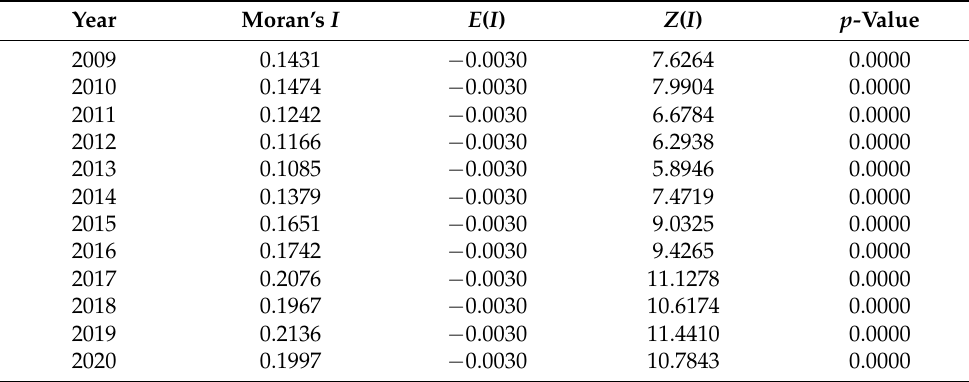
Table 2. Global Moran’s I statistics of PIR in China during